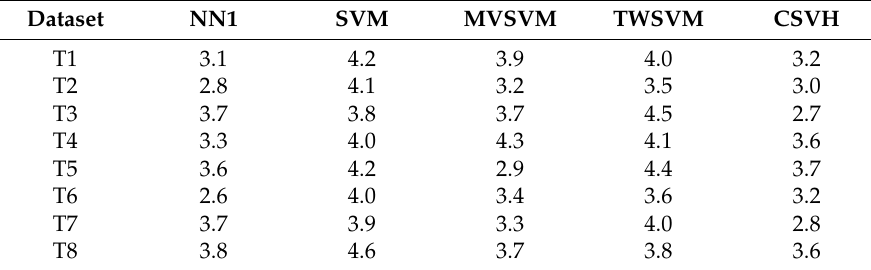
Table 7. The standard deviations of the classifiers on